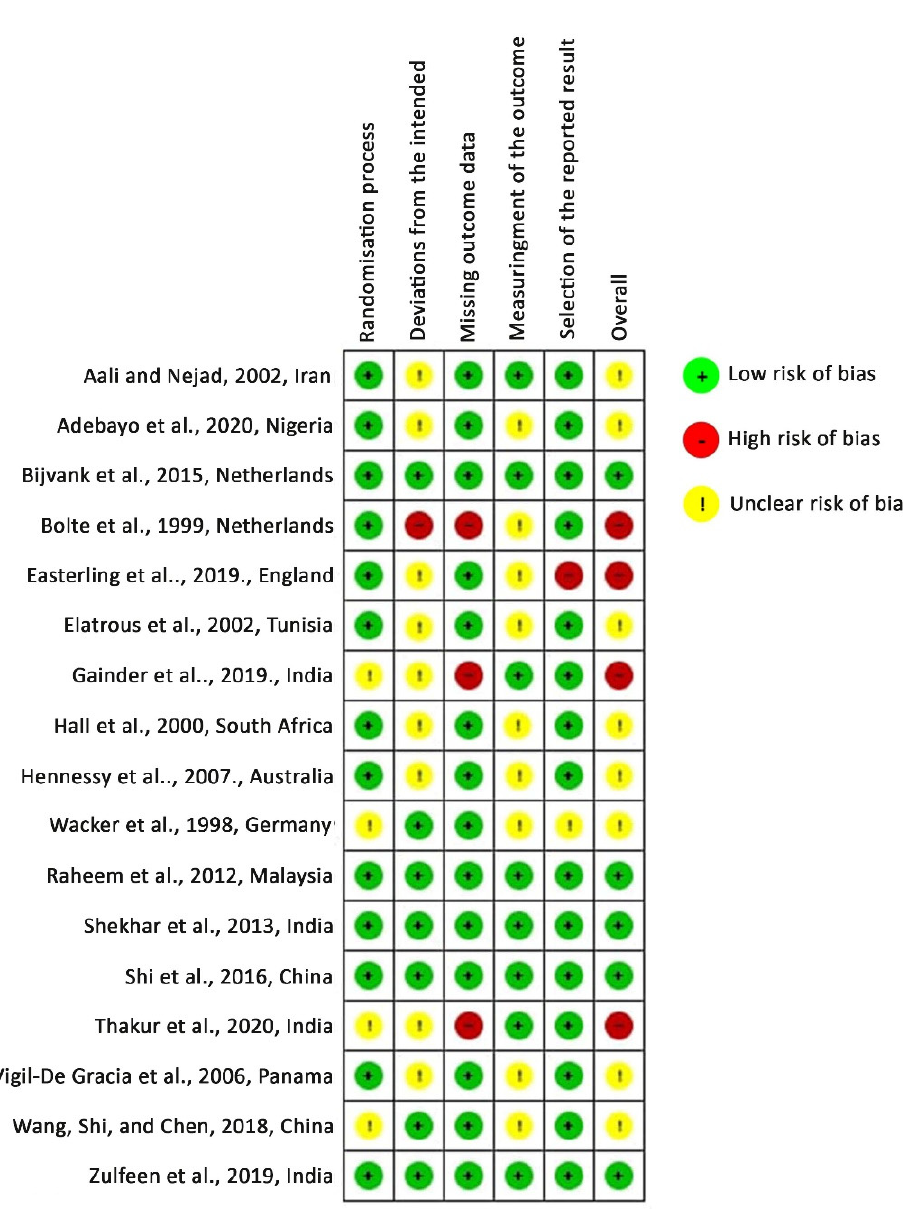
Figure 3. Risk-of-bias assessment: authors’ judgments for risk-of-bias items in each study included. Studies are listed alphabetically by author name.